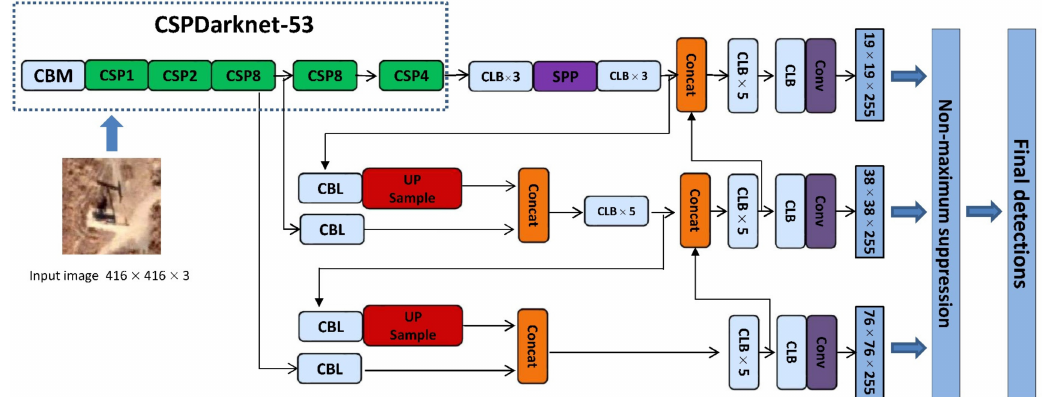
Figure 3. Layer architecture of the YOLO v4 network.